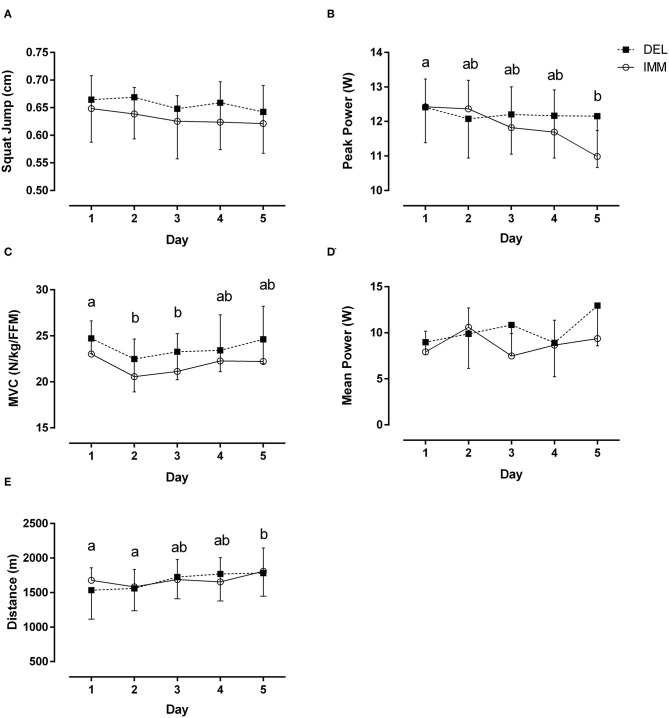
Day to day performance changes in (A) squat jump, (B) peak anaerobic power (C) MVC normalized to fat-free mass (FFM), (D) mean anaerobic power, and (E) distance traveled during multi-stage beep test on successive days of VIT in the evening after consuming protein immediately after (IMM) or the following morning (DEL) after exercise. Means with different letters are significantly different (main effect for time, P < 0.01). Mean ± SD.